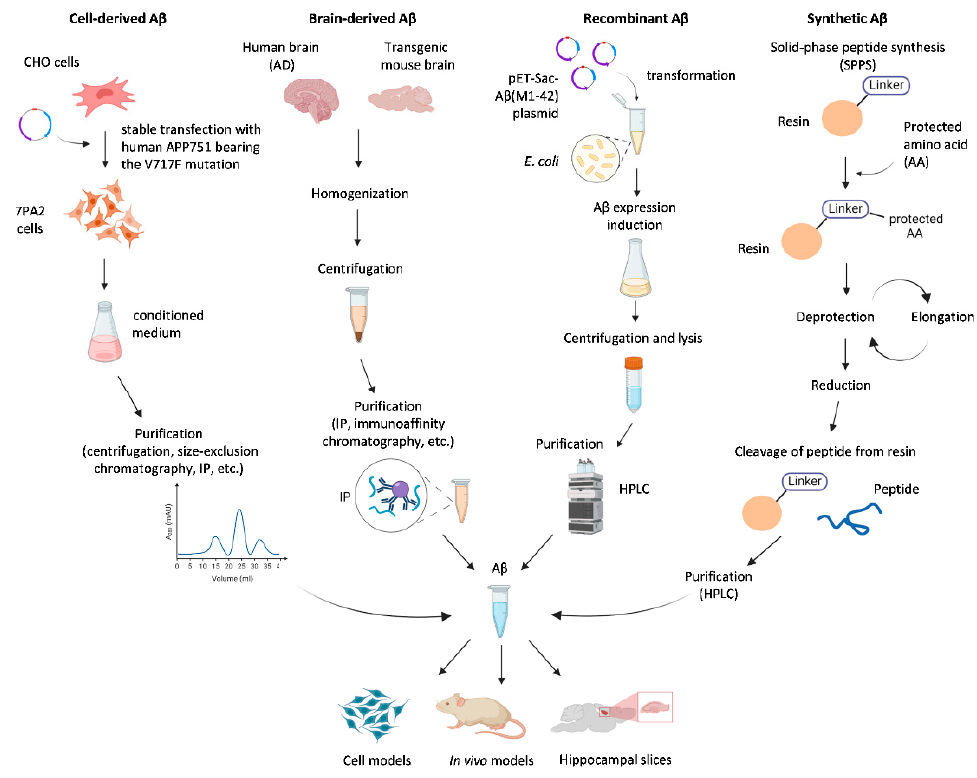
Figure 1. Common sources of beta-amyloid peptide (A β ) used for modelling Alzheimer’s disease (AD)-related processes in vitro and in vivo .